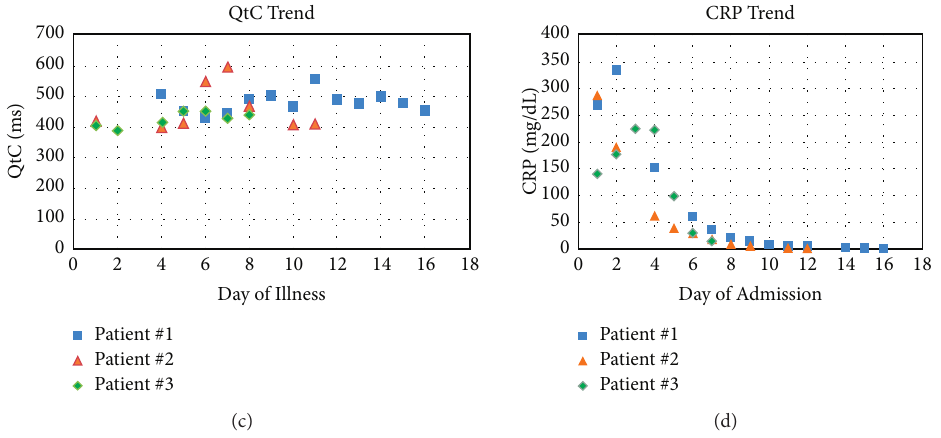
Figure 3: (a) Patients’ BNP trend, (b) patients’ PR interval trend, (c) patients’ QTc trend, and (d) patients’ CRP